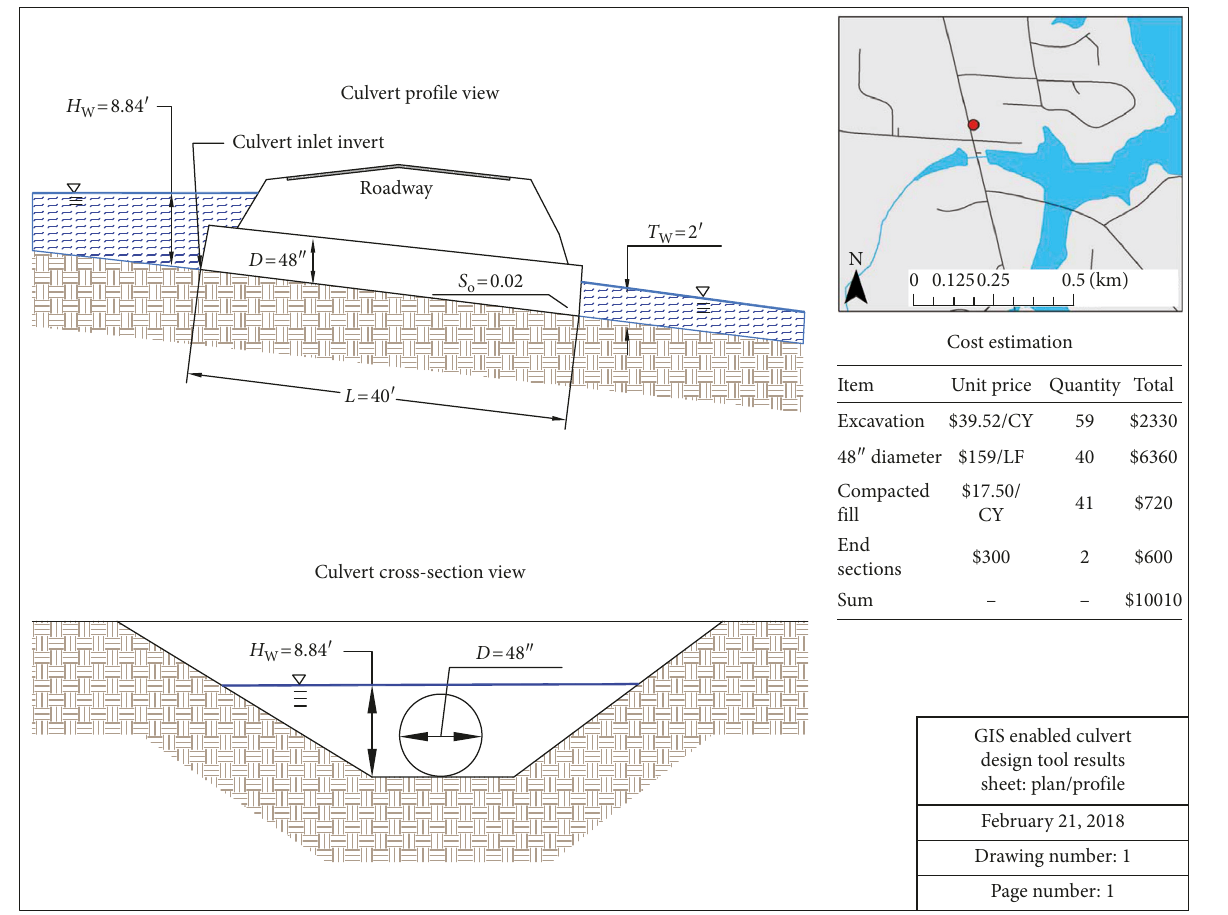
Figure 5: Sample output culvert design